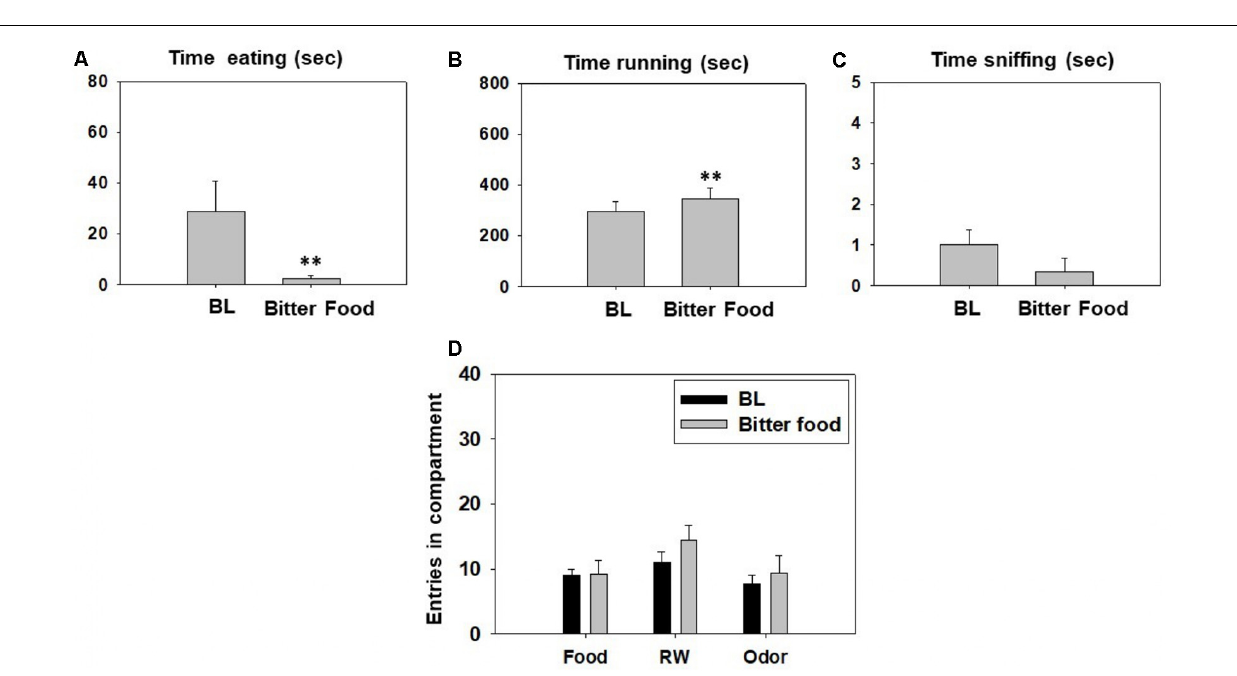
FIGURE 6 | Effect of bittering the sucrose pellets on time eating (A) , time running (B) , time sniffing (C) , entries into compartments (D) , and in the T-maze task assessed during 15 min. Data were analyzed with the Student’s t -test for dependent samples. Bars represent mean ± SEM of accumulated seconds or number of entries. ∗∗ p < 0.01 significantly different from baseline (BL)